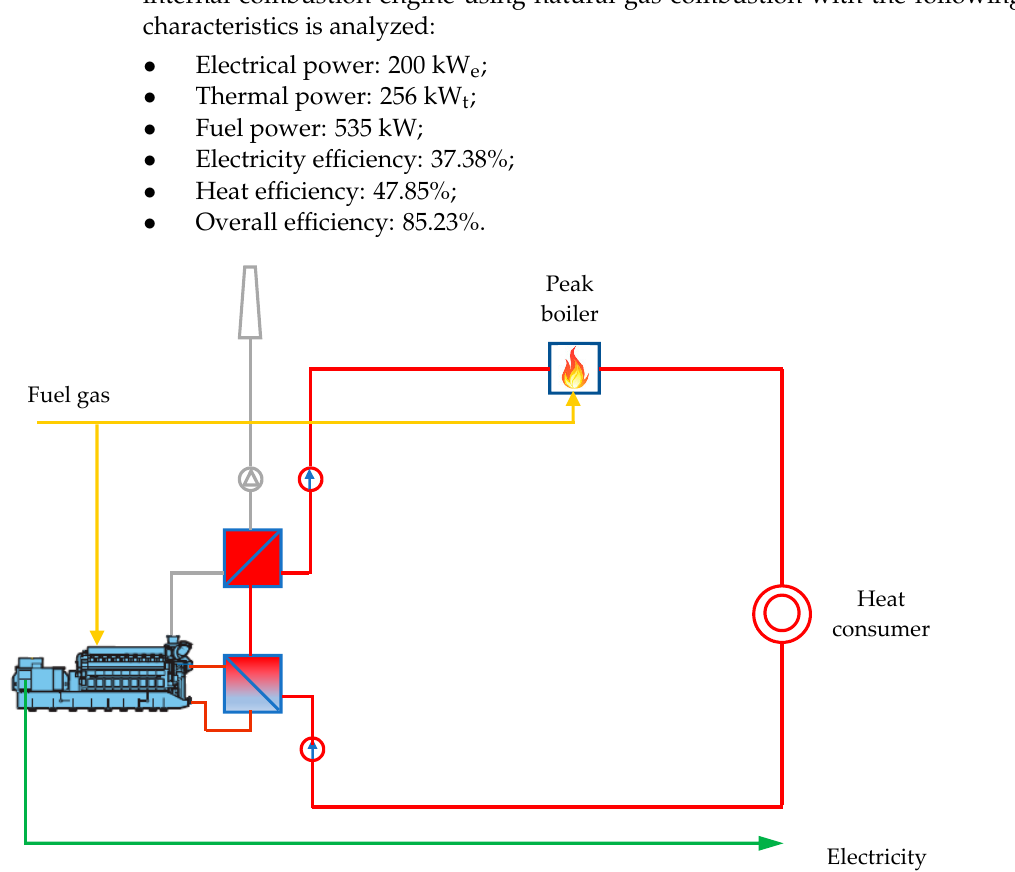
Figure 19. Cogeneration with a single unit and peak boiler.